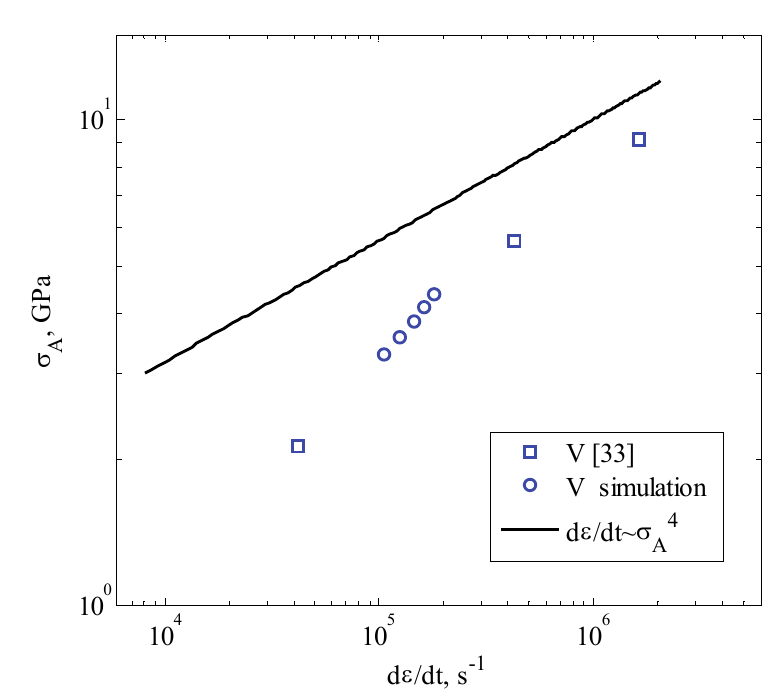
Figure 10: Dependences of the stress amplitude versus the strain rate at the front of the shock wave for vanadium